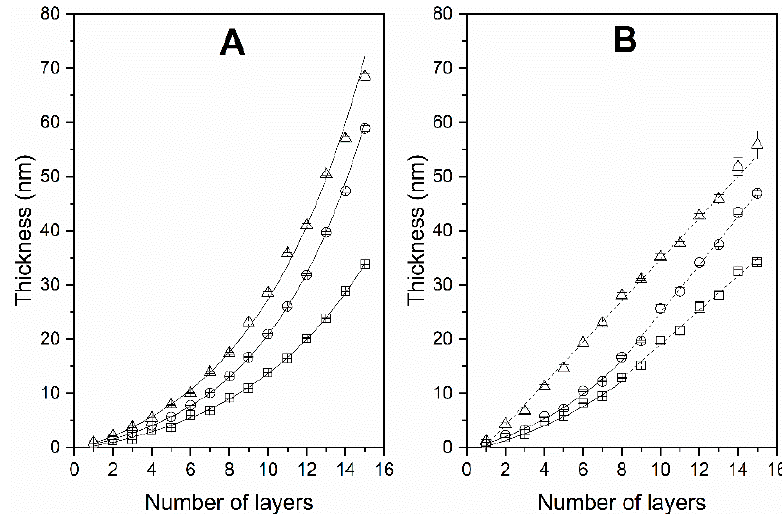
Figure 1. Thickness of polyelectrolyte multilayer s (PEMs) obtained using polycations: C1H (squares), C2H (circles) and CAm (triangles) alternately deposited with AH ( A ) or AAm ( B ). Solid and dashed lines indicate the regions of exponential and linear growth of film thickness, respectively. The thickness data were obtained by ellipsometric measurements after deposition of each polymer layer.